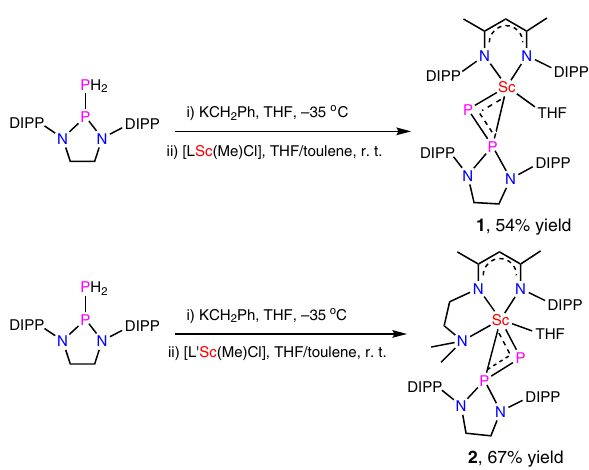
Fig. 1 Synthesis of scandium phosphinophosphinidene